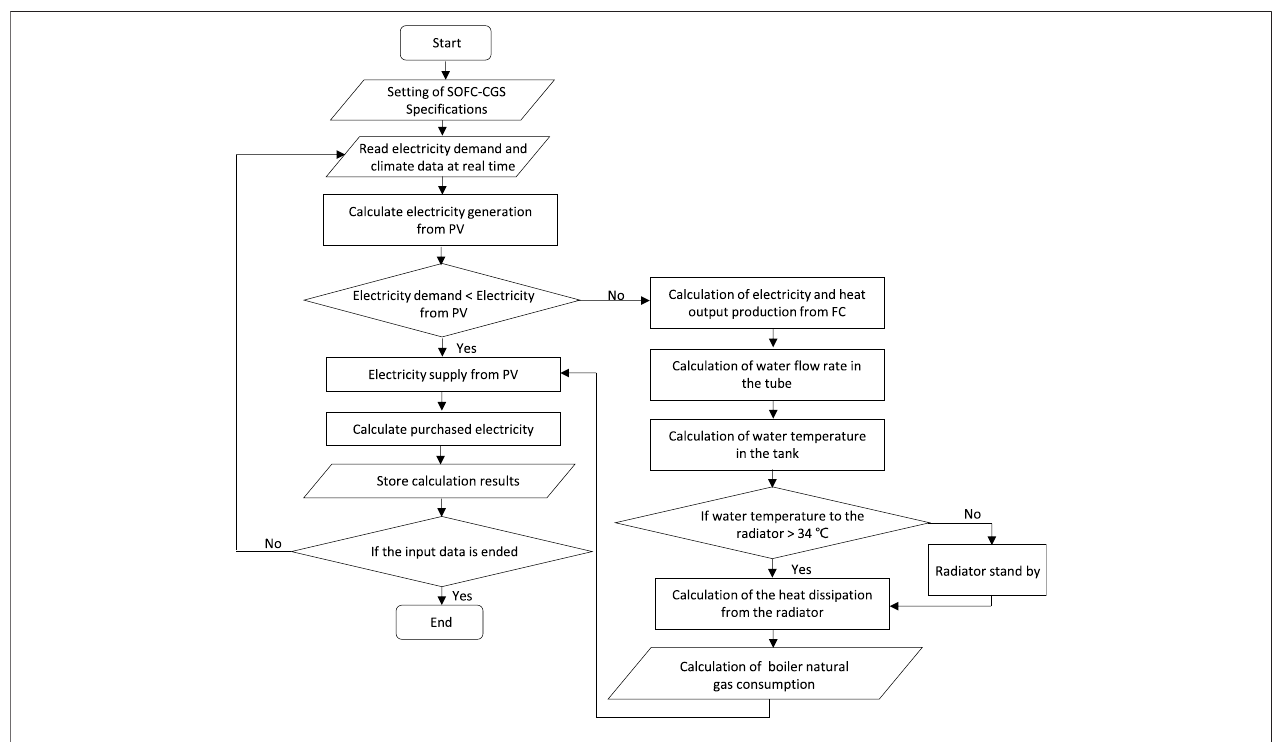
FIGURE 5 | Calculation fl owchart of the integrated SOFC – CGS and PV system